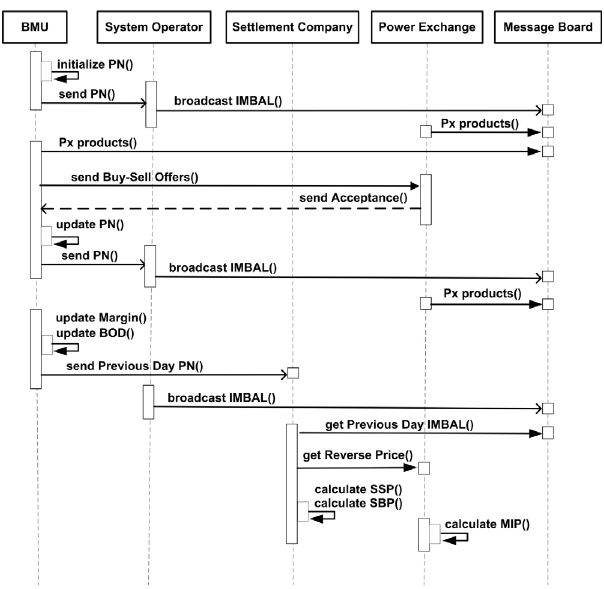
Figure 4. Sequencing chart depicting the scheduled message passing between agents.